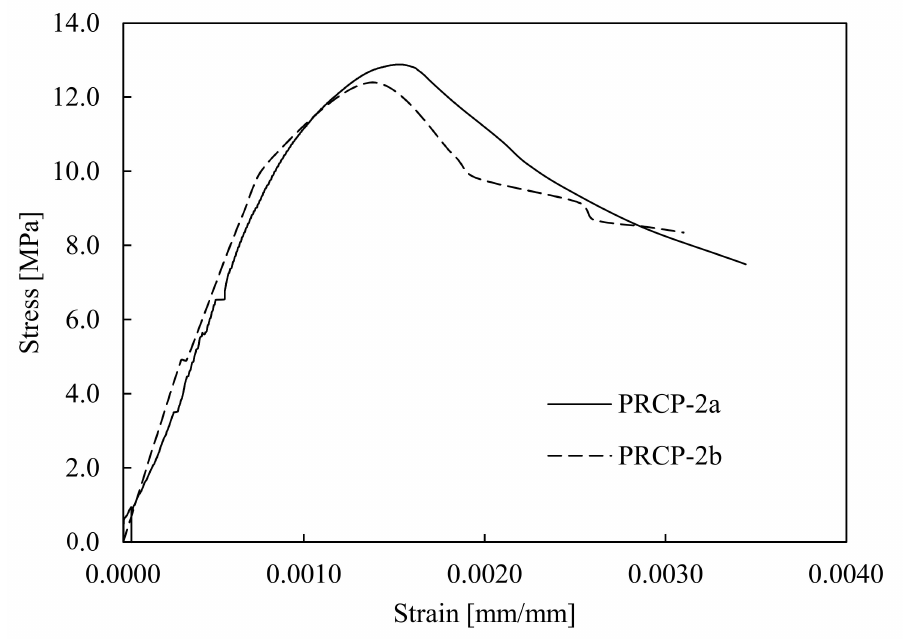
Figure 7. Effective stress versus strain curves of the PCSP-2a and PCSP-2b specimens.